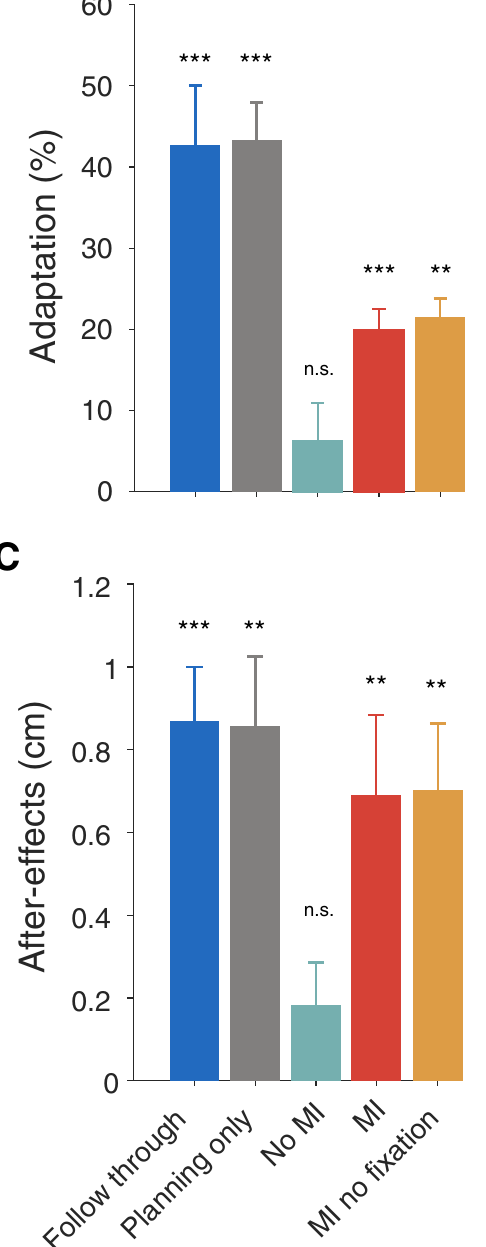
Figure 4. Adaptation and aftereffects. ( A ) Final adaptation measured on follow through channel trials for all participants (mean ± s.e. of final six blocks of exposure). ( B ) Comparison of the adaptation between the pooled follow through group and adaptation measured in the subjects who performed the probe phase in the motor imagery and no-imagery groups (first 4 blocks after exposure). ( C ) MPE during the post-exposure phase (mean ± s.e. of first two blocks) showing aftereffects. Here we consider only the no motor imagery and motor imagery participants who did not perform the probe phase. Therefore all participants shown in ( C ) experienced the same number of exposure trials before after-effects were assessed. Asterisks show statistical significance of final adaptation level ( A ) and after-effects ( C ) compared to pre-exposure, and of differences between groups ( B ). MI = motor imagery; FT = follow through; n.s. = not